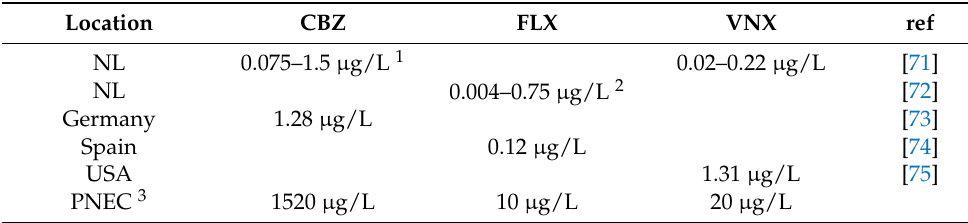
Table 5. Concentrations in surface